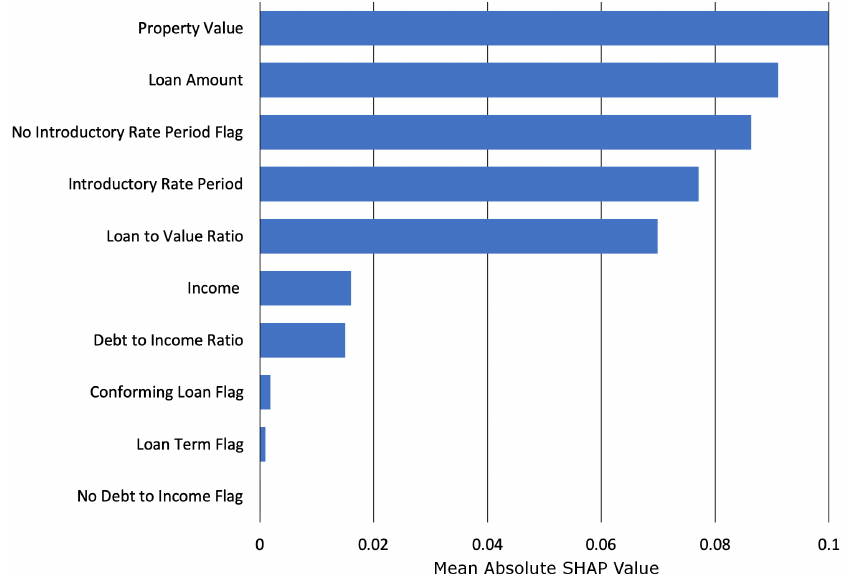
Figure 5. Global mean absolute Deep SHAP feature importance for g XNN ( X ) on the mortgage test